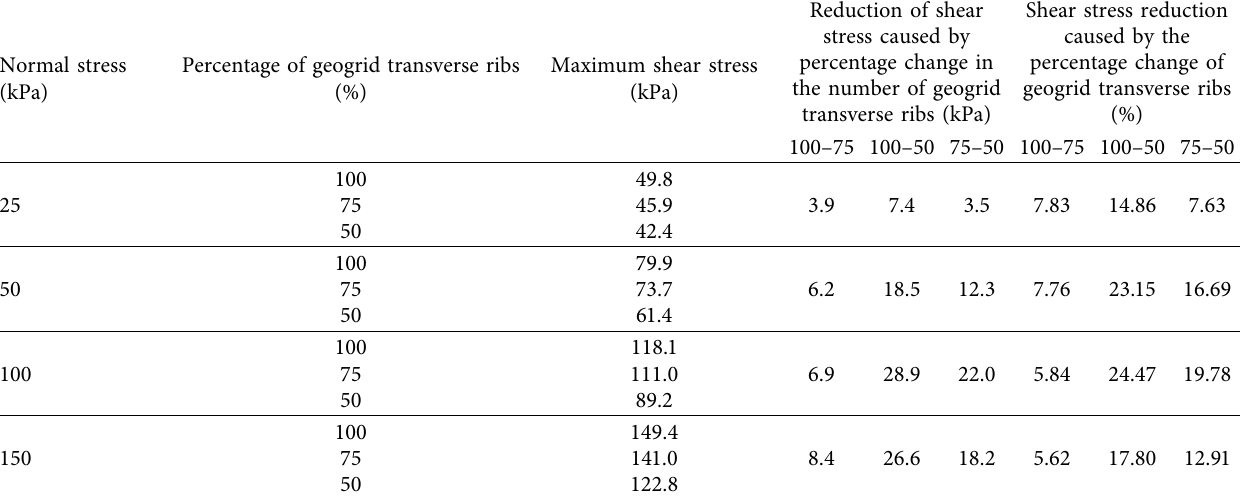
Note . 100-75 in Table 5 indicates that the percentage of geogrid transverse ribs changes from 100% to